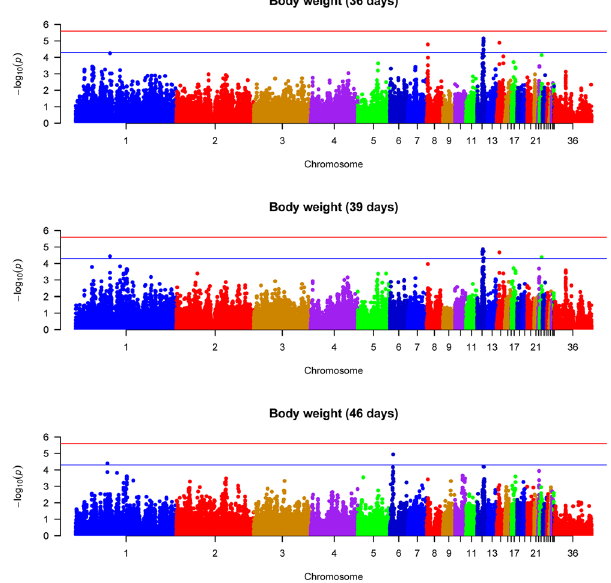
Figure 1. Manhattan plots of genome wide association results for body weight traits using mixed linear model analysis. Chromosomes 29, 30 and 36 represent linkage groups LGE22C19W28_E50C23, LGE64, and chromosome Z, respectively. Red and blue lines indicate genome wide and suggestive significance thresholds, respectively.